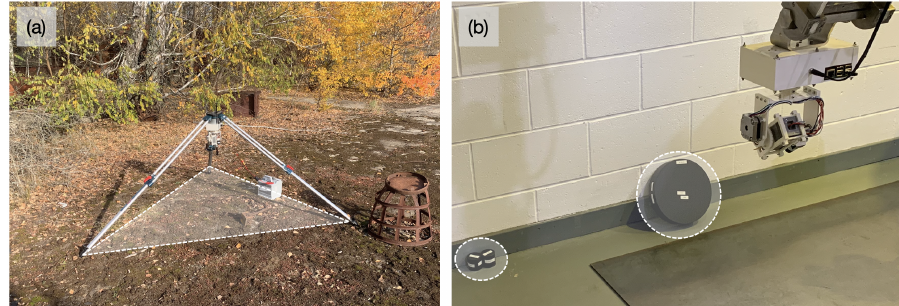
Figure 3. The CC-RIAS device deployed; (a) in the field using a tripod to survey for fine-scale fallout particle material, and (b) on the end of a PaR manipulation system as used for remote- particle material, and ( b ) on the end of a PaR manipulation system as used for remote-handling handling applications at nuclear facilities. The scanning area is highlighted in (a), with the 137 Cs applications at nuclear facilities. The scanning area is highlighted in ( a ), with the 137 Cs radioactive radioactive sources highlighted in (b). sources highlighted in ( b ).